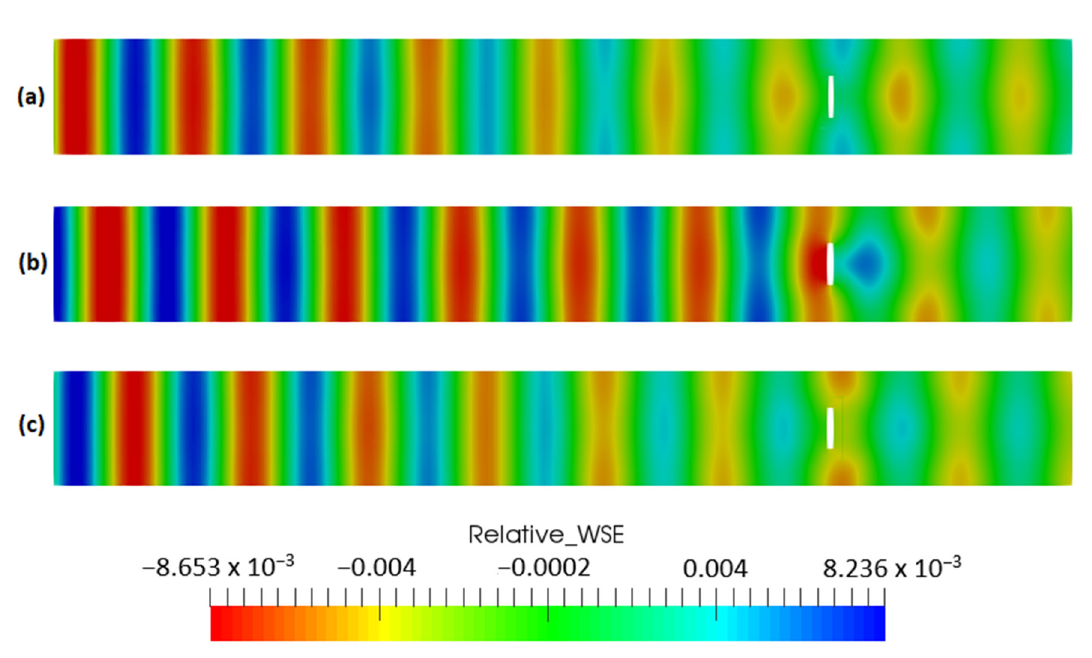
Figure 14. Relative wave surface elevation when the flap is at three different positions: ( a ) Maximum oscillation (landwards), ( b ) upright position, and ( c ) minimum oscillation (seawards).